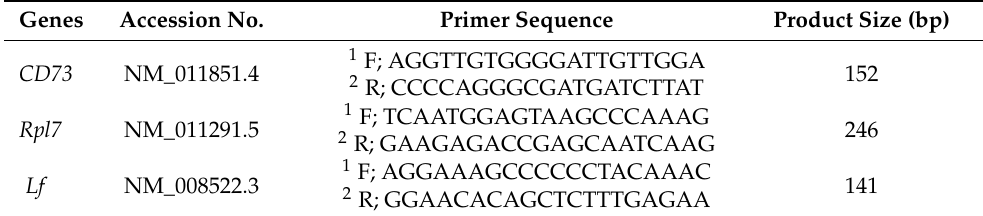
Table 1. Primer sequences and RT-PCR